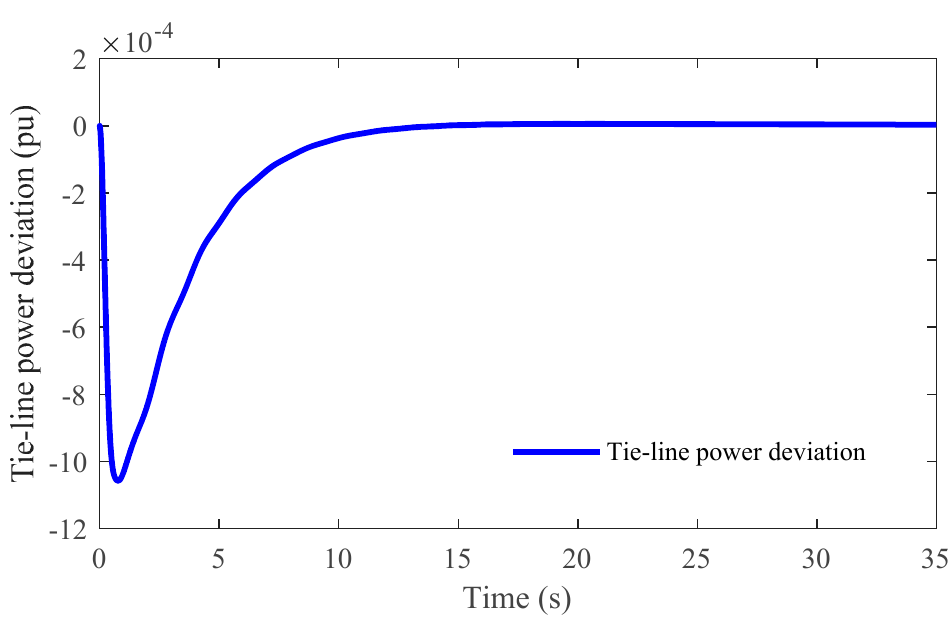
Figure 9. Tie line power deviation under the parametric uncertainty condition with the proposed FC FOPI-FOPD controller.